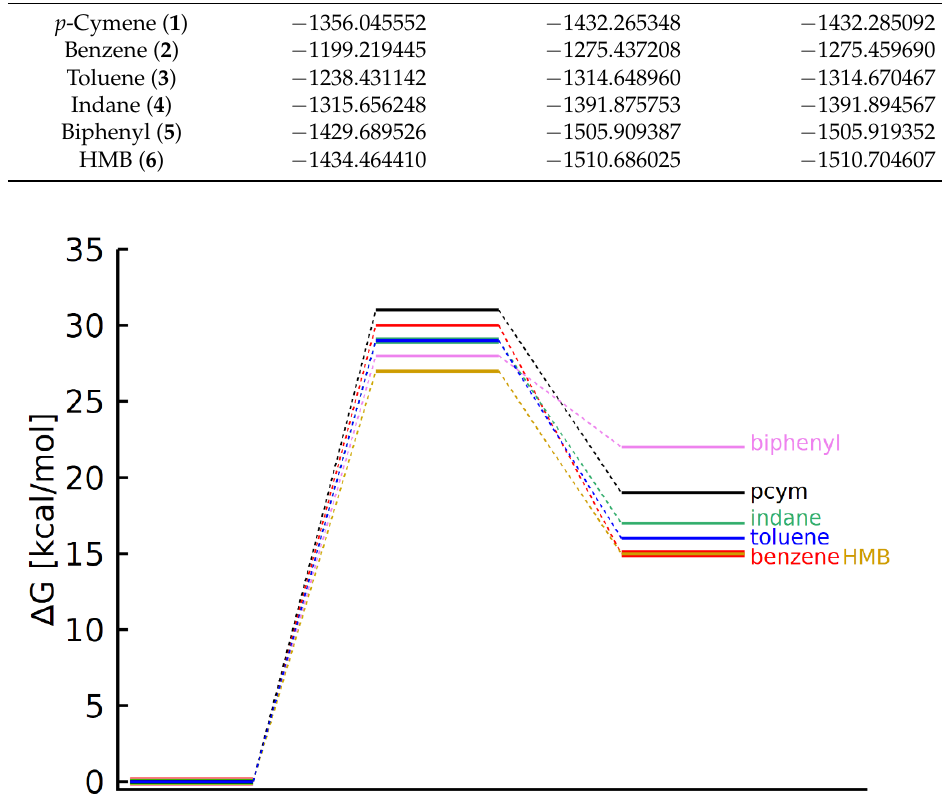
Table 2. Computed energies in [a.u.] of Ru-naphthoquinone-complexes in their initial- and transition- state, as well as their corresponding aqua complexes. Arene Reactant [a.u.] Transition State [a.u.] Aqua-Complex [a.u.]